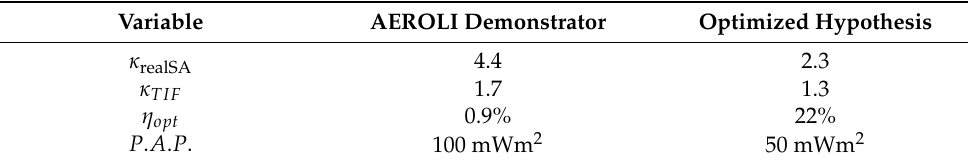
Table 2. Main variables for the performance estimation after Equation